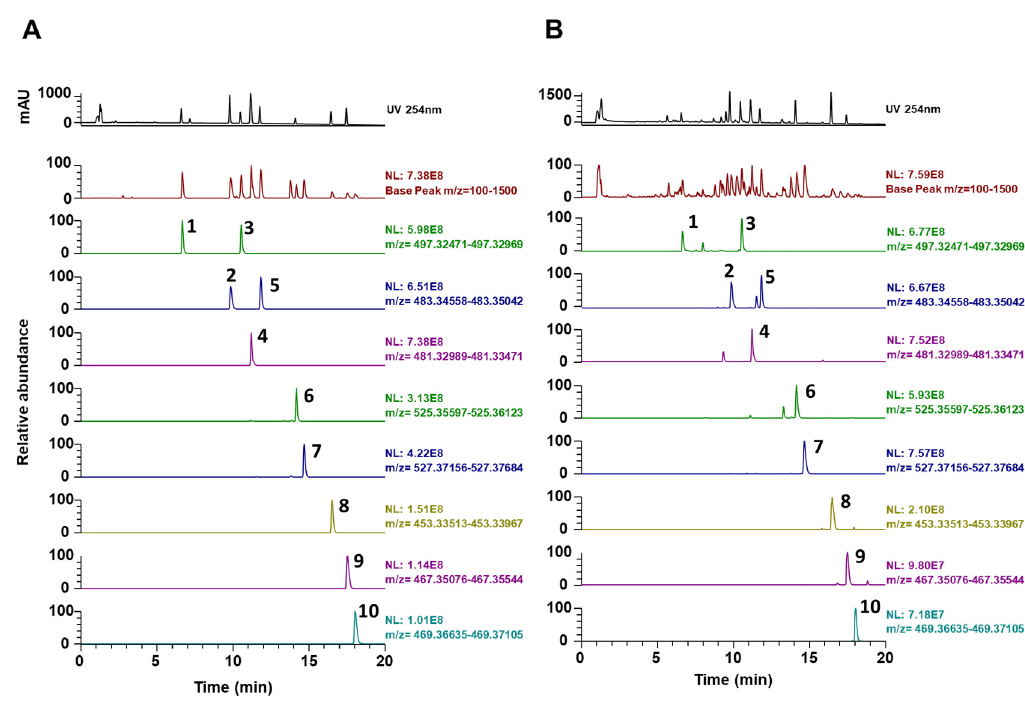
Figure 3. PC analysis using UHPLC-DAD–MS / MS. ( A ) Ultraviolet, base peak, and extracted-ion chromatograms of authentic reference standards. ( B ) Ultraviolet, base peak, and extracted-ion chromatograms of PC. 1, 6 α -hydroxypolyporenic acid C; 2, dehydrotumulosic acid; 3, poricoic acid A; 4, polyporenic acid C; 5, 3-epidehydrotumulosic acid; 6, dehydropachymic acid; 7, pachymic acid; 8, dehydrotrametenolic acid; 9, dehydroeburicoic acid; 10, eburicoic acid.